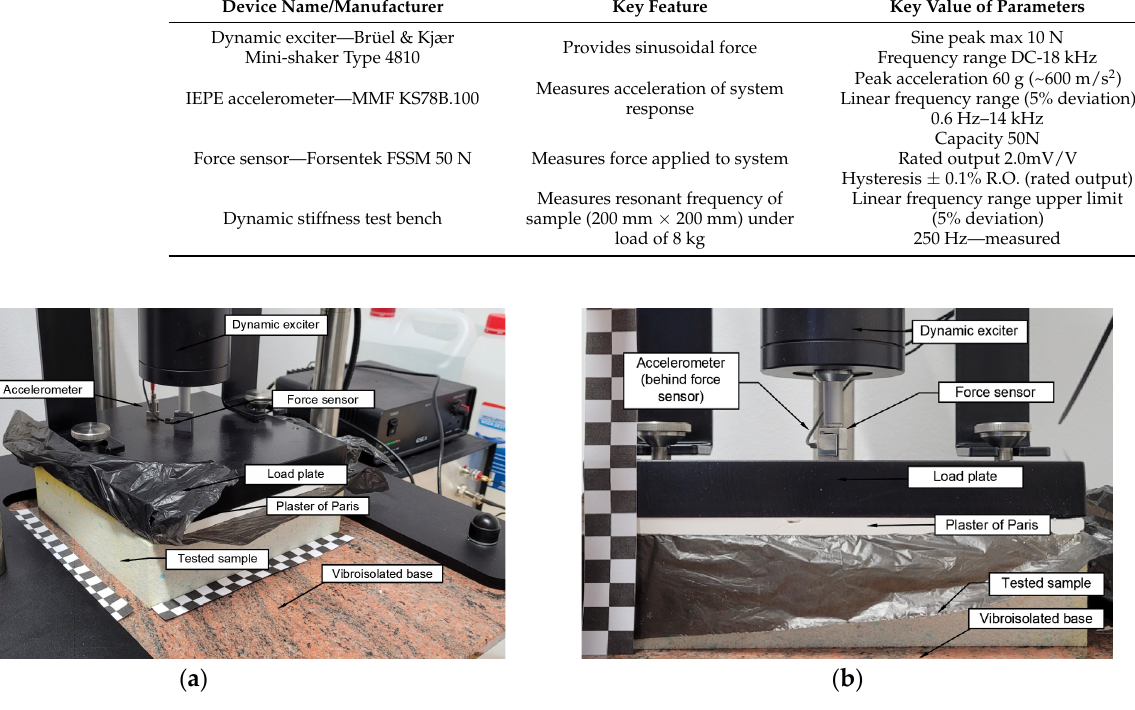
Table 3. Nominal and actual density of tested samples, with Young’s modulus (own elaboration)